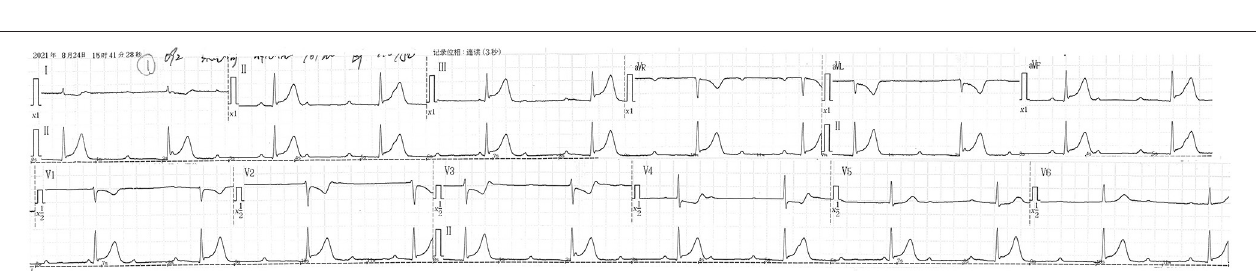
FIGURE 1 | Twelve-lead electrocardiogram showed lead II, III, aVF ST-segment depression of 0.1mv with T-wave inversion.